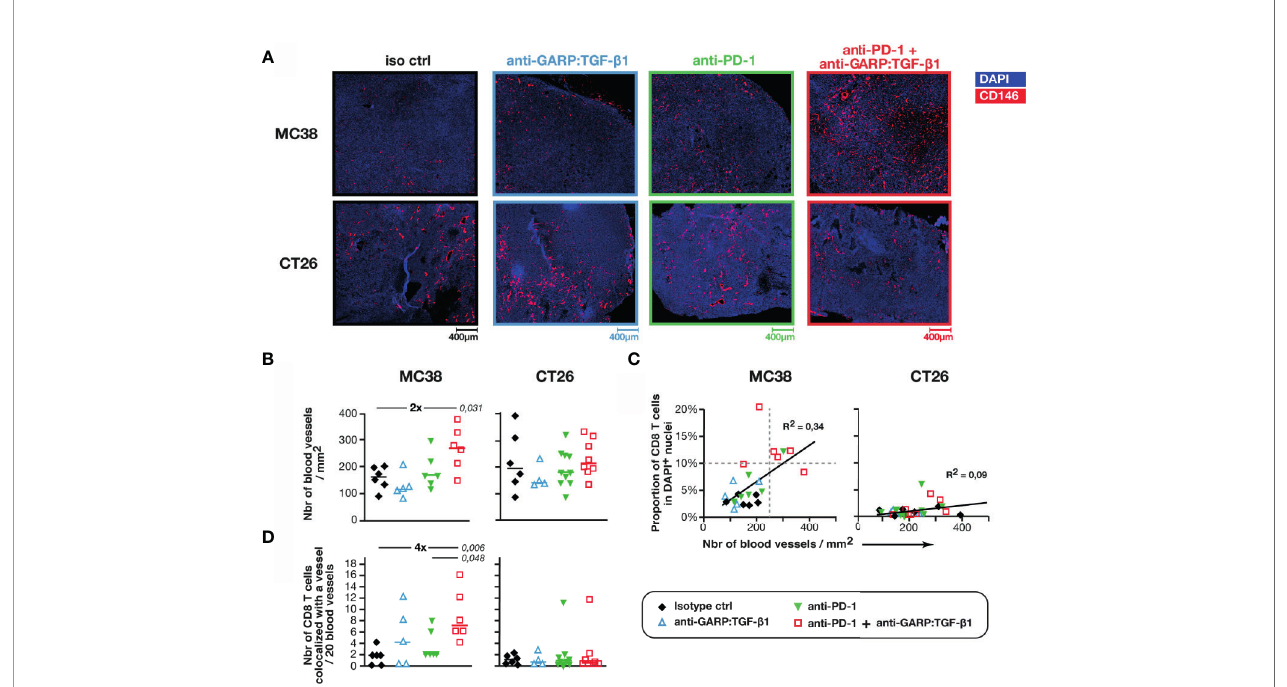
FIGURE 3 | Combined GARP:TGF- b 1/PD-1 blockade increases blood vessel density in MC38, but not in CT26 tumors. Sections of FFPE tumors from Figures 1A, B analyzed by mIF and quantitative digital imaging. (A, B) Representative images and quanti fi cation of immunostaining for CD146 (red) and DAPI (blue). Sections were analyzed with the Halo software to identify and quantify the number of blood vessel-like objects ( i.e. CD146 + objects) per mm 2 of section. Mean of two tumor sections per mouse. (C) Correlation between the proportion of CD8 T cells ( Figure 1B ) and the density of blood vessels. Linear regressions and corresponding coef fi cients of determination (R 2 ) are indicated. (D) Number of CD8 T cells colocalized with a blood vessel ( i.e. DAPI + CD3 + CD8 + CD146 + events) per 20 blood vessels. Data points represent the values in individual mice. Horizontal bars: median per group. P values <0.05, calculated with a two-sided Wilcoxon test, are indicated in italics. Numbers in bold: fold-change between the indicated groups. Results from one experiment for MC38 (n = 5 – 6 mice/group), and pooled from two independent experiments for CT26 (n = 3 – 6